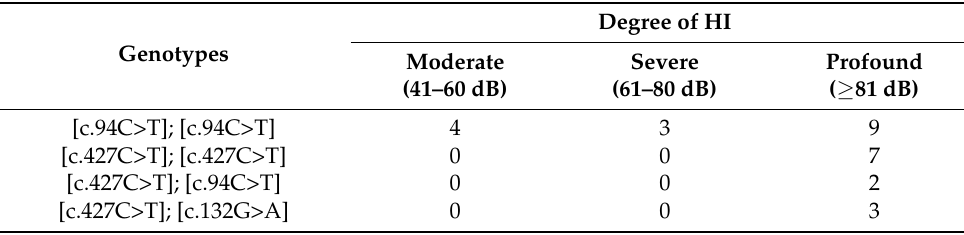
Table 4. Comparison of GJB2 genotypes and the degree of